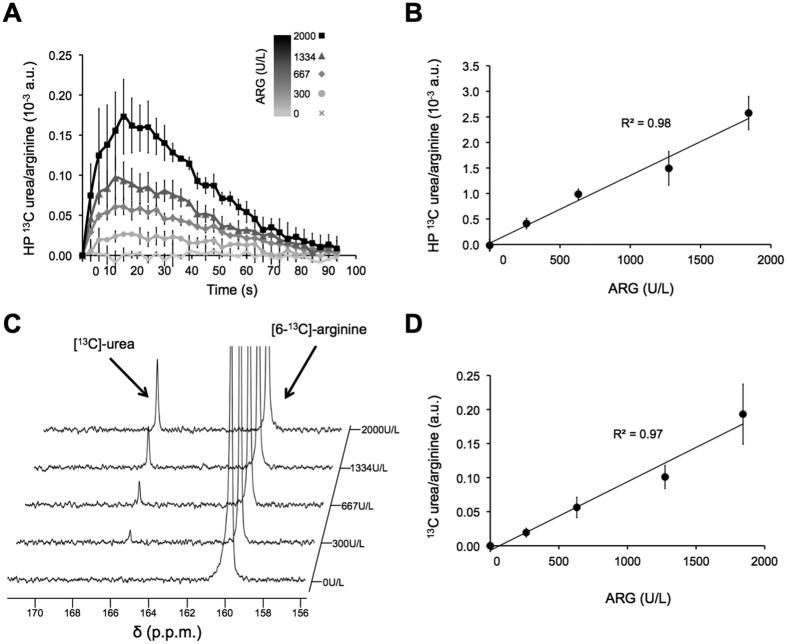
Hyperpolarized [13C]-urea production is linearly correlated to ARG concentration.(A) Build-up of hyperpolarized [13C]-urea normalized to area-under-the-curve of hyperpolarized [6-13C]-arginine over time illustrating increased urea production with ARG concentration. Maximum at 16.5 ± 4.5 s post maximum arginine signal was observed with ARG concentration at and above 300 U/L. (B) Area-under-the-curve (AUC) of hyperpolarized [13C]-urea build-up as a function of ARG concentration, showing a correlation between hyperpolarized [13C]-urea production and enzyme concentration. (C) Stack-plot of thermal equilibrium spectra and (D) [13C]-urea and [6-13C]-arginine integral ratios from thermal equilibrium spectra as a function of ARG concentration, confirming hyperpolarized [13C]-urea detection.